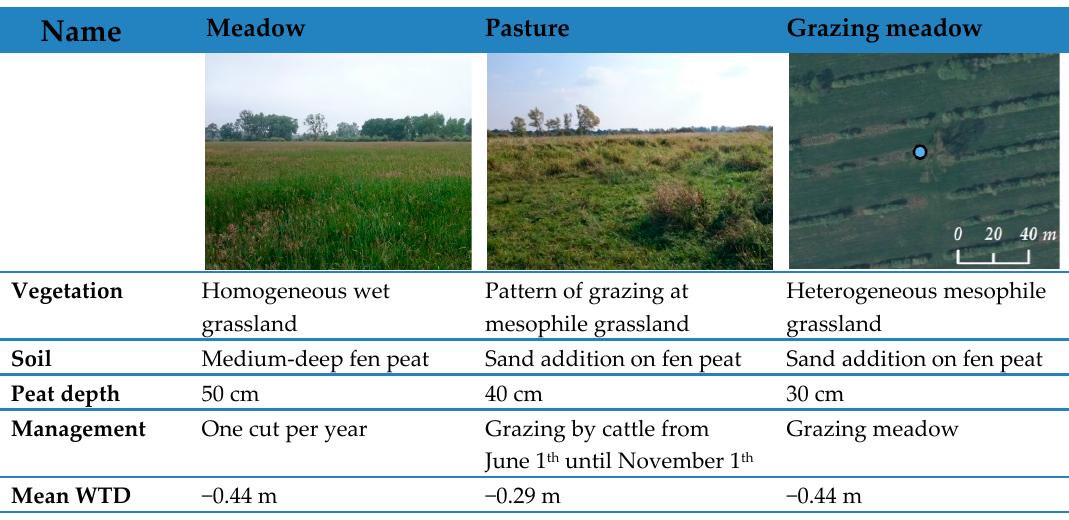
Figure 3. Exemplary study sites for which time series will be shown, including key information on vegetation, soil, peat depth, grassland management practices and mean water table depth (WTD).